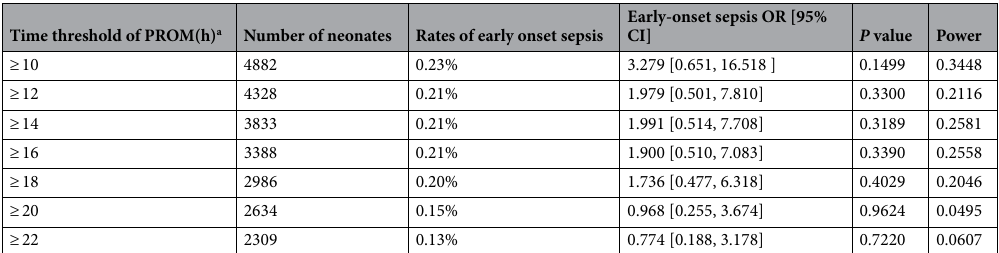
Table 4. Multivariable analysis of length of time of PROM and neonatal outcomes: Adjusted OR of other factors at time thresholds with significant differences of early-onset sepsis according to length of time of PROM. Controlling for the city where the hospital locates, the mother’s age, education level, chorioamnionitis, induction of labor, prenatal antibiotic treatment, mode of delivery, amniotic fluid pollution, neonate’s sex, Apgar Score. a Length of time of PROM from 0 h through specific time threshold.